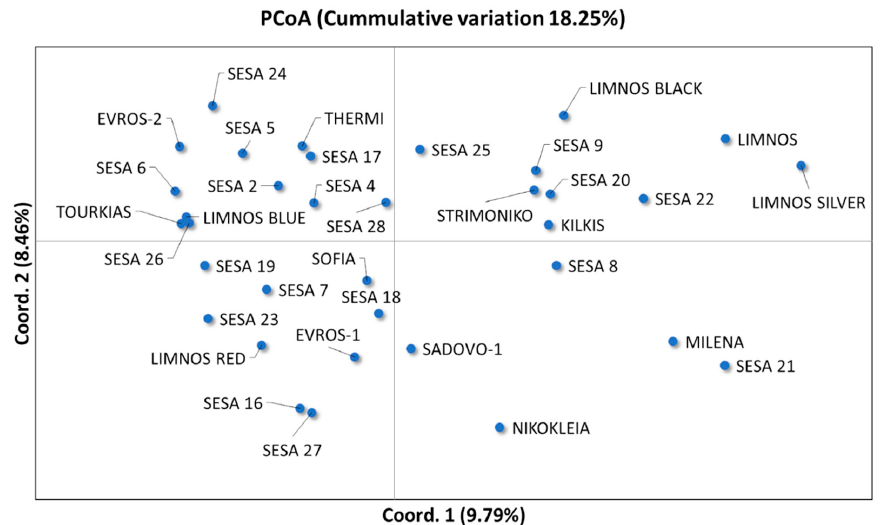
Figure 5. Principal coordinate analysis (PCoA) of the first two coordinates (Coord. 1 and Coord. 2) based on the EST-SSR data for the 35 sesame landraces.